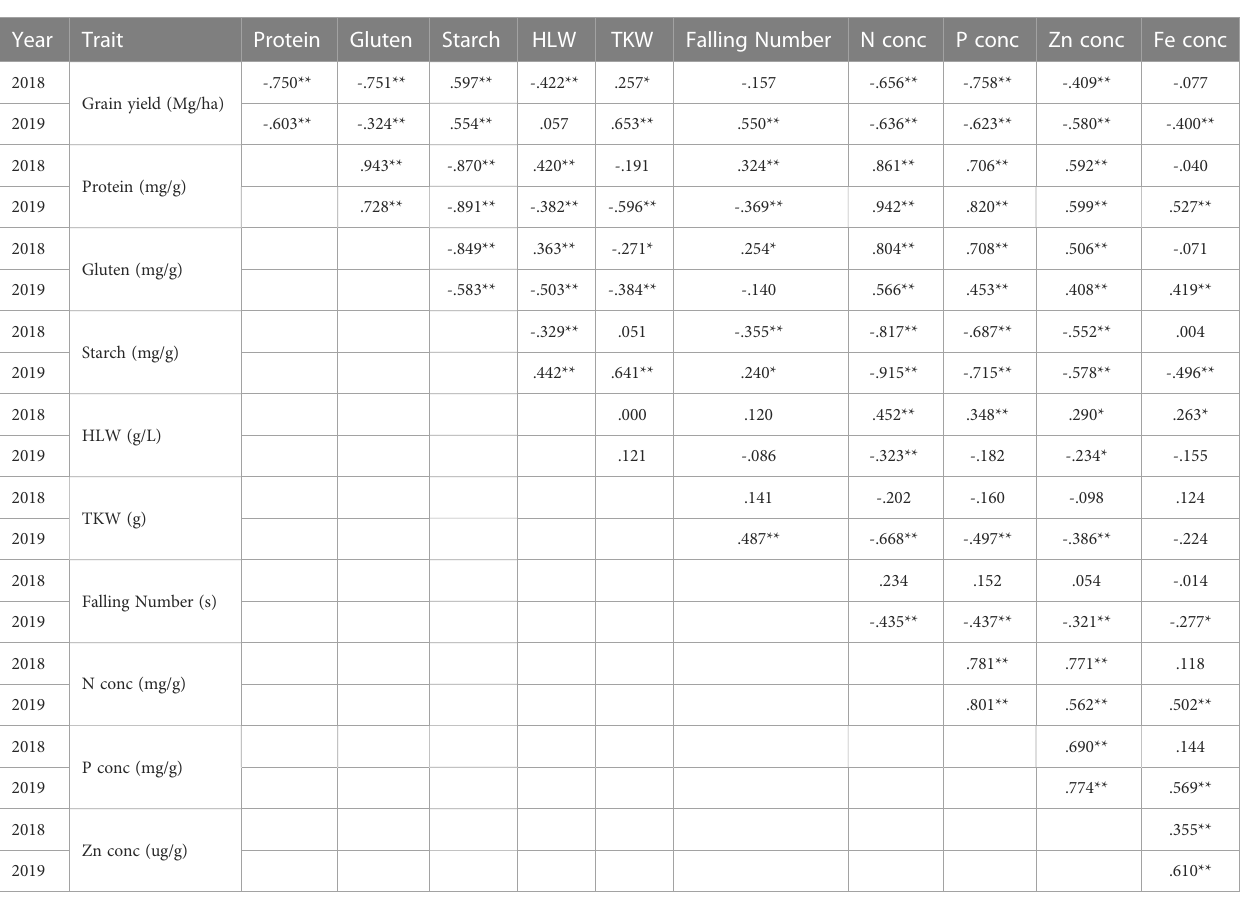
TABLE 4 Spearman ’ s rank correlation coef fi cients between grain yield and quality parameters per